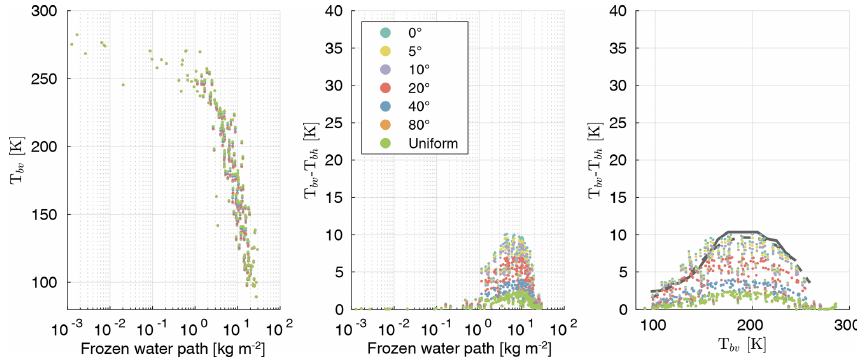
Figure 12. Simulated brightness temperature at 166GHz for 200 randomly selected atmospheric profiles. For each of these atmospheric profiles the scattering properties of the azimuthally randomly oriented scatterers are orientation-averaged over seven different distributed β angles with zero mean and different standard deviations. The different colors denote the standard deviation of the β angle distribution and the distribution type. For the used scatterers, see Table 3. The solid gray line denotes the mean polarization difference over tropical ocean from GMI observations at 166GHz of Gong and Wu (2017), and the dashed gray line denotes the mean polarization difference over tropical ocean from MADRAS observations at 157GHz of Defer et al. (2014).